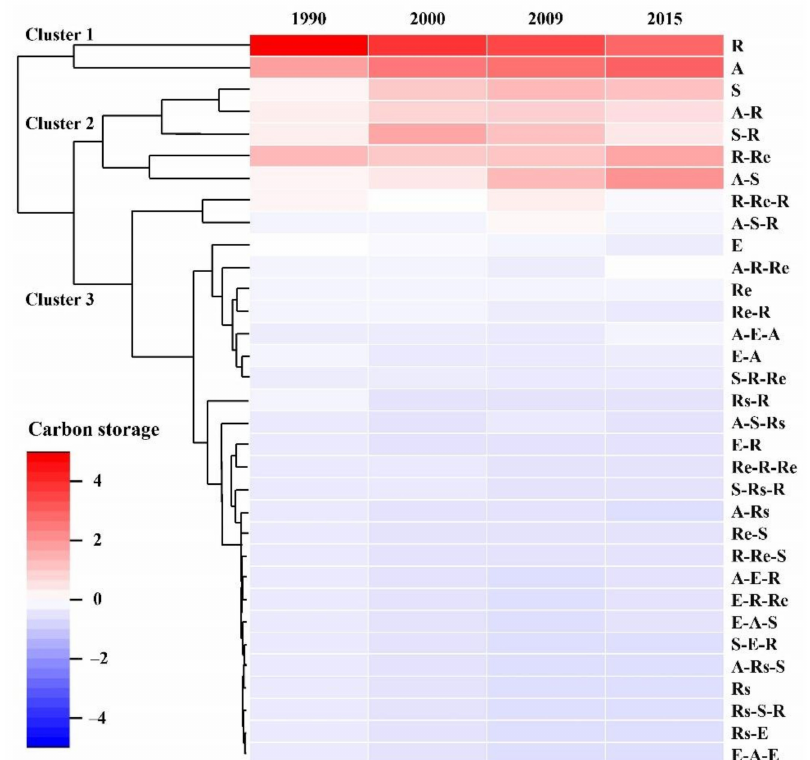
Figure 7. The clustering analysis of blue carbon storage driven by the major processes in the Shang- hai coastal area. Note: Driving Process—A: Accretion; S: Succession; Rs: Regressive succession; E: Erosion; R: Reclamation; Re: Restoration. For example, R-Re-R means that the area was under recla- mation between 1990 and 2000, restored between 2000 and 2009 and then again under reclamation between 2009 and